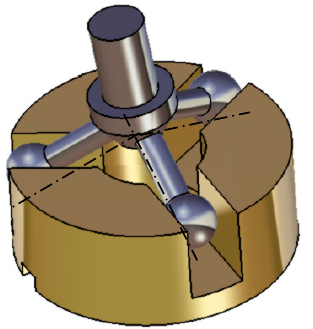
Figure 11. Tripod joint, point–surface contact.